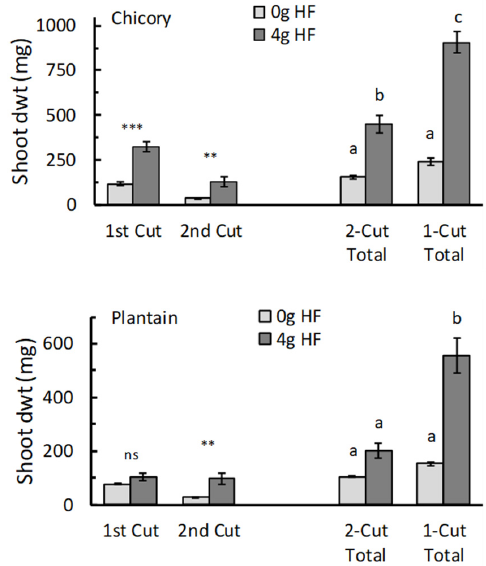
Figure 4. The influence of HexaFrass™ (4 g per pot) on the shoot growth (mean ± SE) of chicory and plantain at five weeks (1st Cut) and after two weeks of regrowth (2nd Cut). The total shoot growth of the cut plants (2 ‐ Cut Total) and plants that were harvested only once after seven weeks (1 ‐ Cut Total) are also presented. Difference between 0 g and 4 g HexaFrass™ treatments tested by unpaired t ‐ tests; ns—no significant difference, ** p < 0.01, *** p < 0.001. Total harvests compared using ANOVA with HF (0 g vs. 4 g) and the cutting regime (1 ‐ cut vs. 2 ‐ cut) as factors. Letter codes separate treatments for each plant using LSDs at p < 0.005.